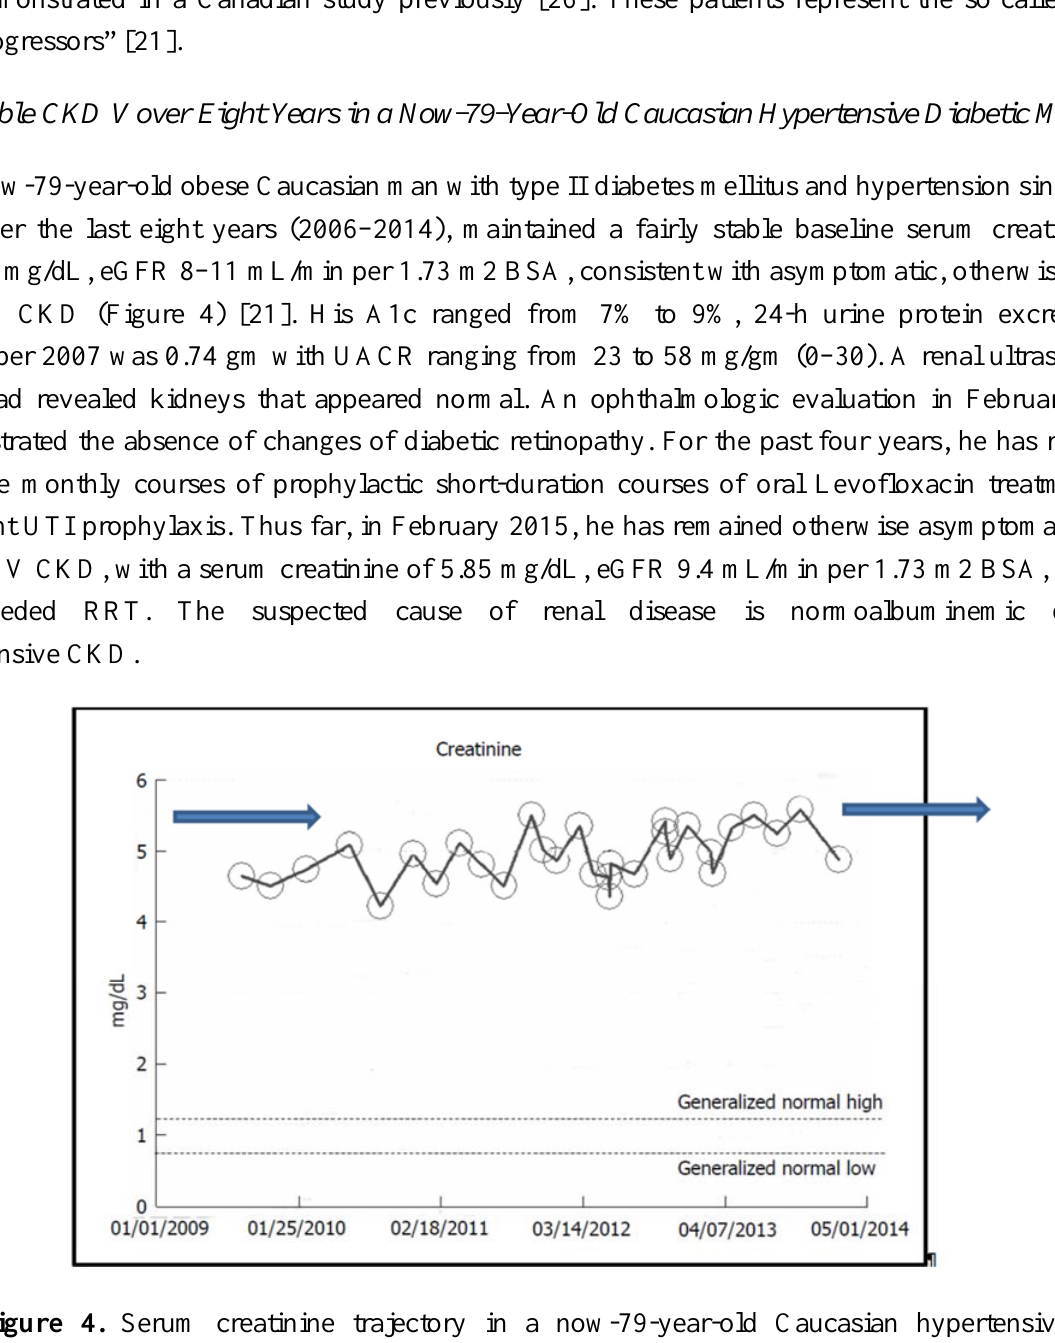
Figure 4. Serum creatinine trajectory in a now-79-year-old Caucasian hypertensive, diabetic male with stable CKD V between 2006 and 2014, serum creatinine of 4.5–5.5 mg/dL, eGFR 8–11 mL/min per 1.73 m 2